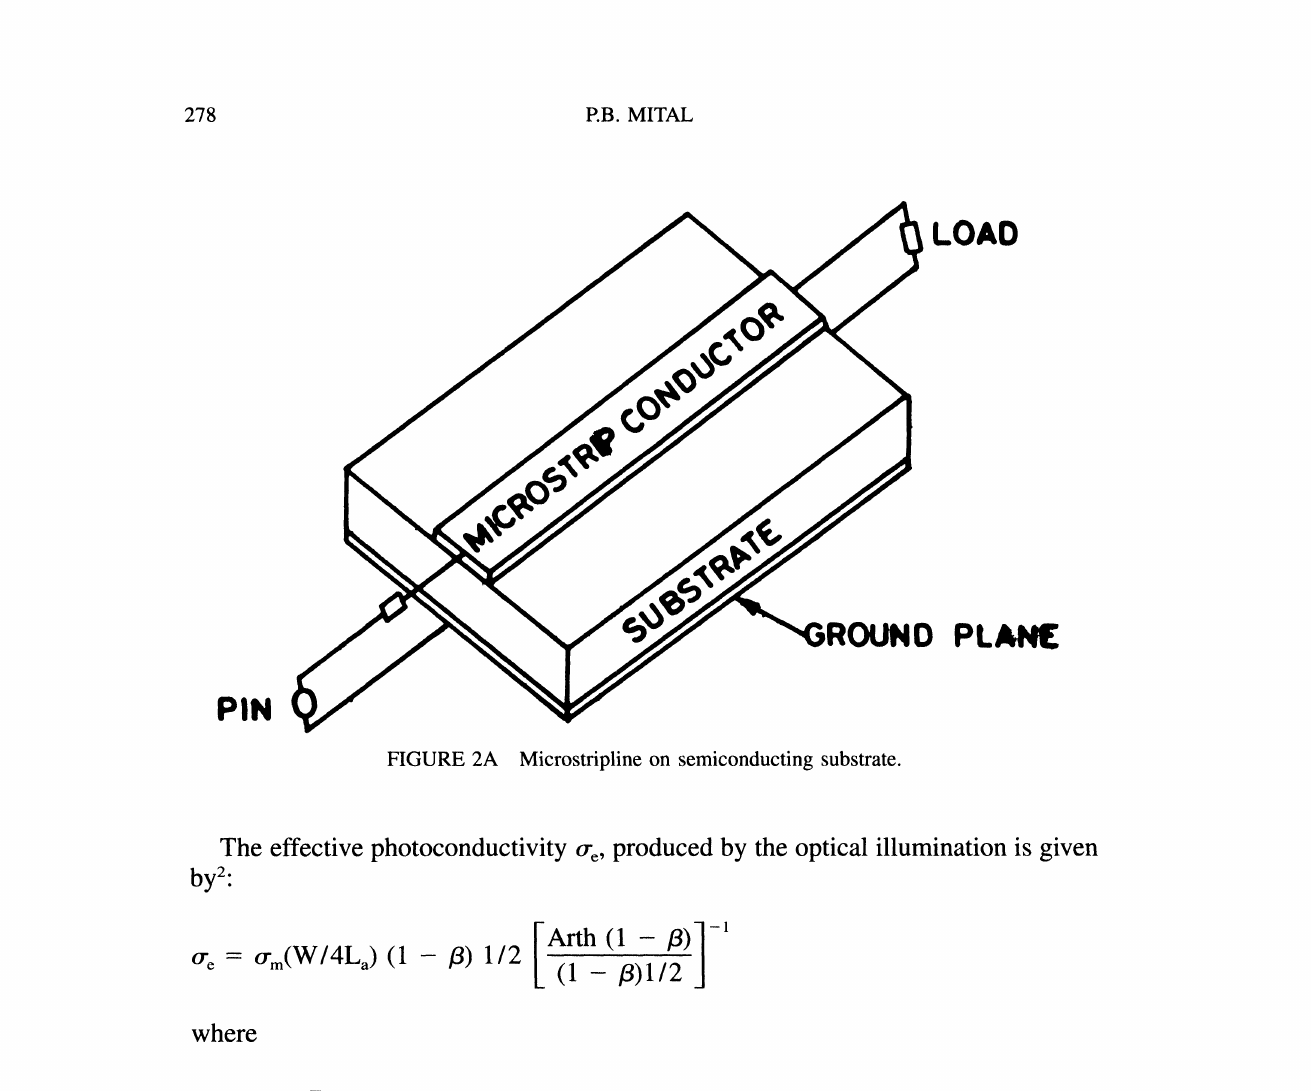
FIGURE 2A Microstripline on semiconducting substrate.